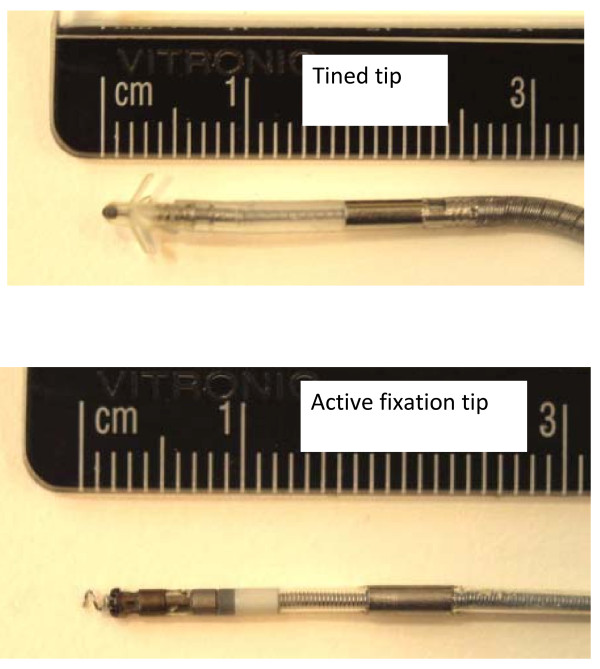
Pacemaker lead tips.